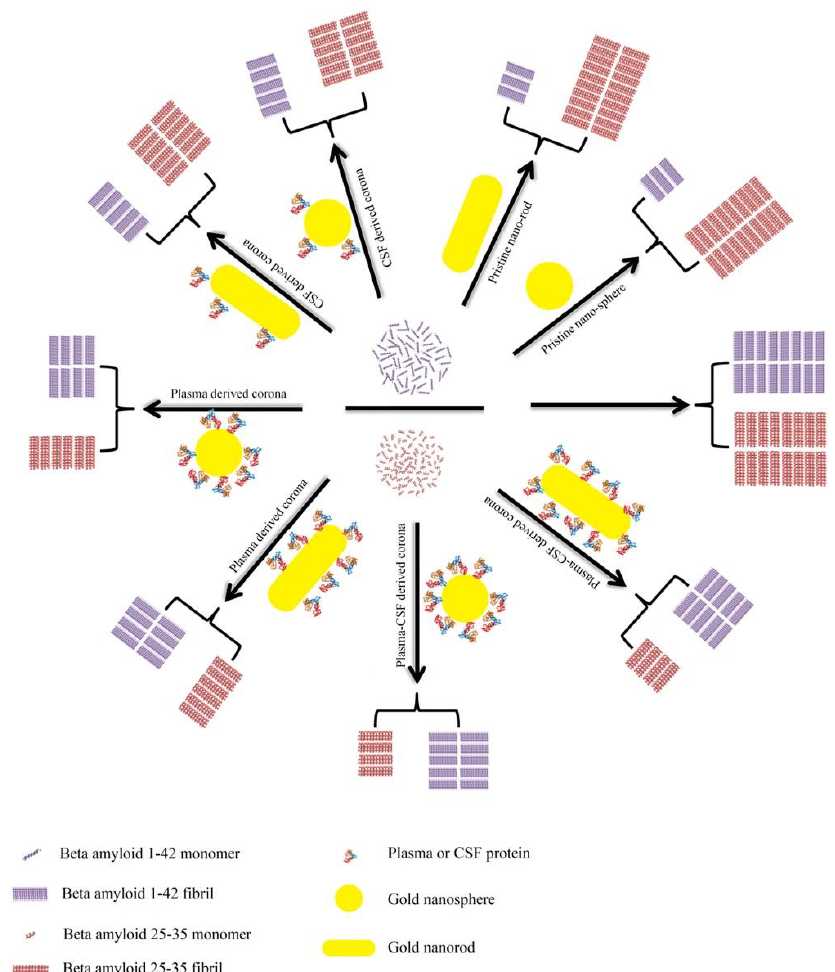
Figure 12. Schematic representation of the effects of bare/corona-coated gold nanospheres/nanorods on the fibrillation of A β 25–35 and A β 1–42 . Reprinted with permission from [183]. Copyright (2018) American Chemical Society.